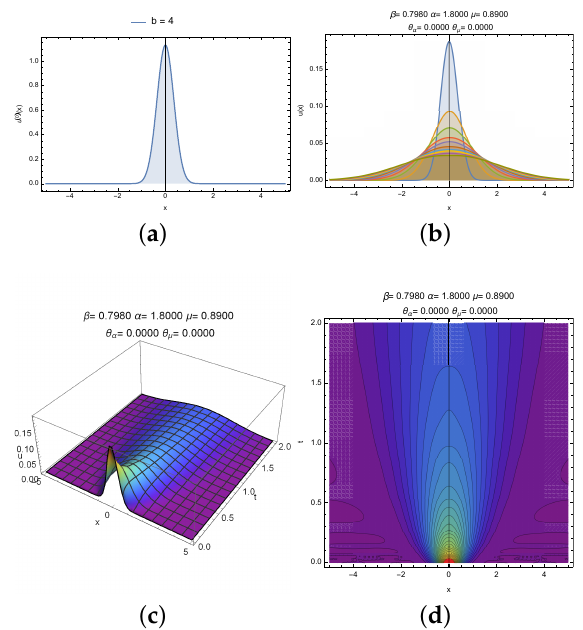
(cid:14) √ Figure 1. ( a ) Initial distribution u ( 0 ) ( x ) = 2 π e − 4 x 2 used in the approximation of the fFP equation (35); ( b ) approximation of fFP for different times ( t ∈ { 0.1,0.3,0.5,0.7,0.9,1.1,1.3,1.5,1.7,1.9 } , top down) using a normalized Gaussian with amplitude b = 4; ( c ) 3D graph of the approximation; and ( d ) contour plot of the approximation. The fractional exponent are given on top of the graphs ( b ), ( c ), and ( d ). Skewness parameters are zero resulting to a symmetric representation.